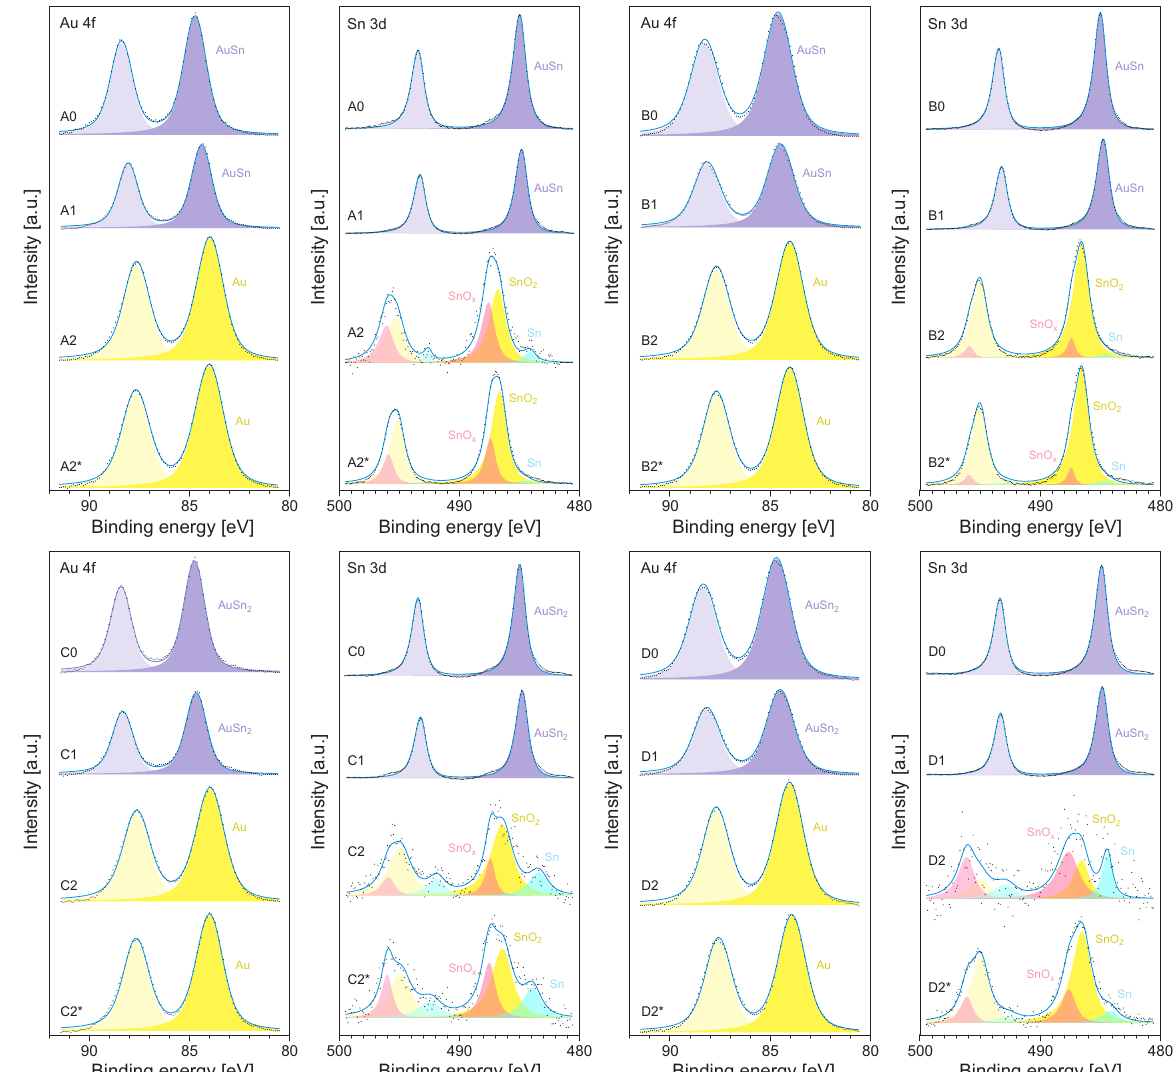
Figure 5. X-ray photoelectron spectroscopy (XPS) spectra (Au 4f and Sn 3d peaks) of the samples: X0—as prepared, X1—heated at 200 ◦ C, X2—heated at 200 ◦ C and then oxidized at 800 ◦ C, and X2*—oxidized at 800 ◦ C (without the heating at 200 ◦ C), where X = A, B, C, or